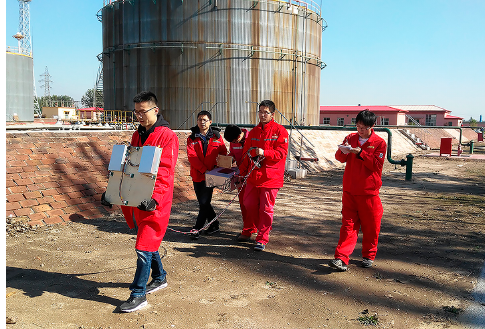
Figure 7. Field testing for the buried pipeline.